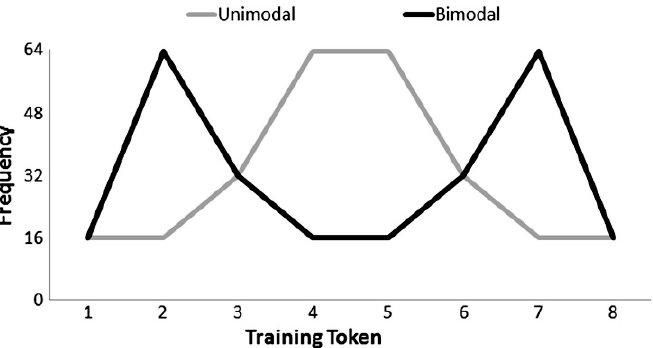
Figure 2. Frequency of occurrence for each training token encountered by listeners in the unimodal (grey line) and bimodal (black line) conditions. Figure from [55].